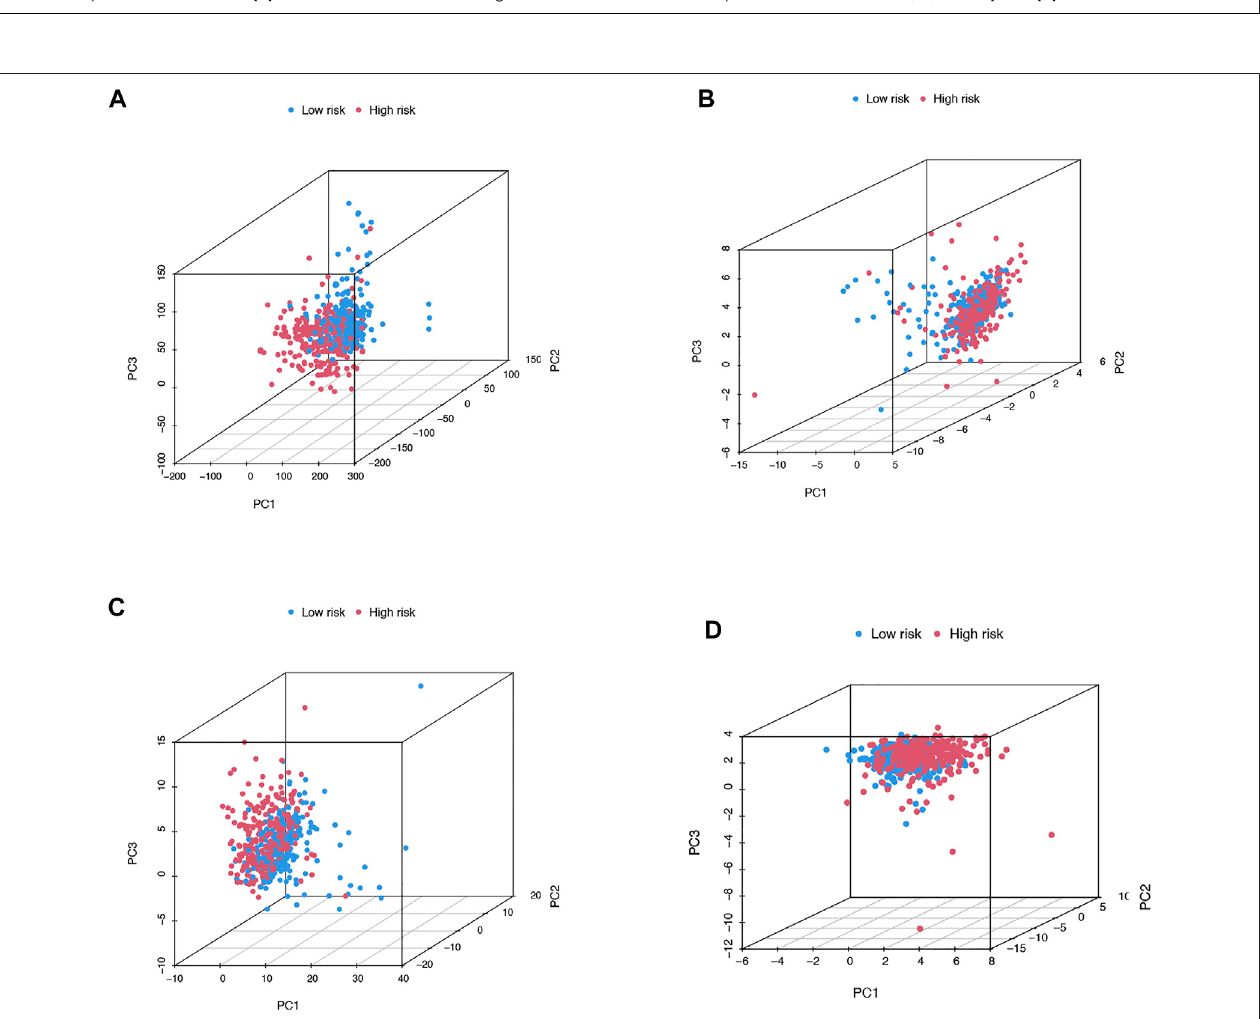
FIGURE6| PCAinbothgroupsofpatients.PCAofallgenes (A) .PCAofcuproptosisgenes (B) .PCAofcuproptosis-relatedlncRNAs (C) .PCAofrisklncRNAs (D) .